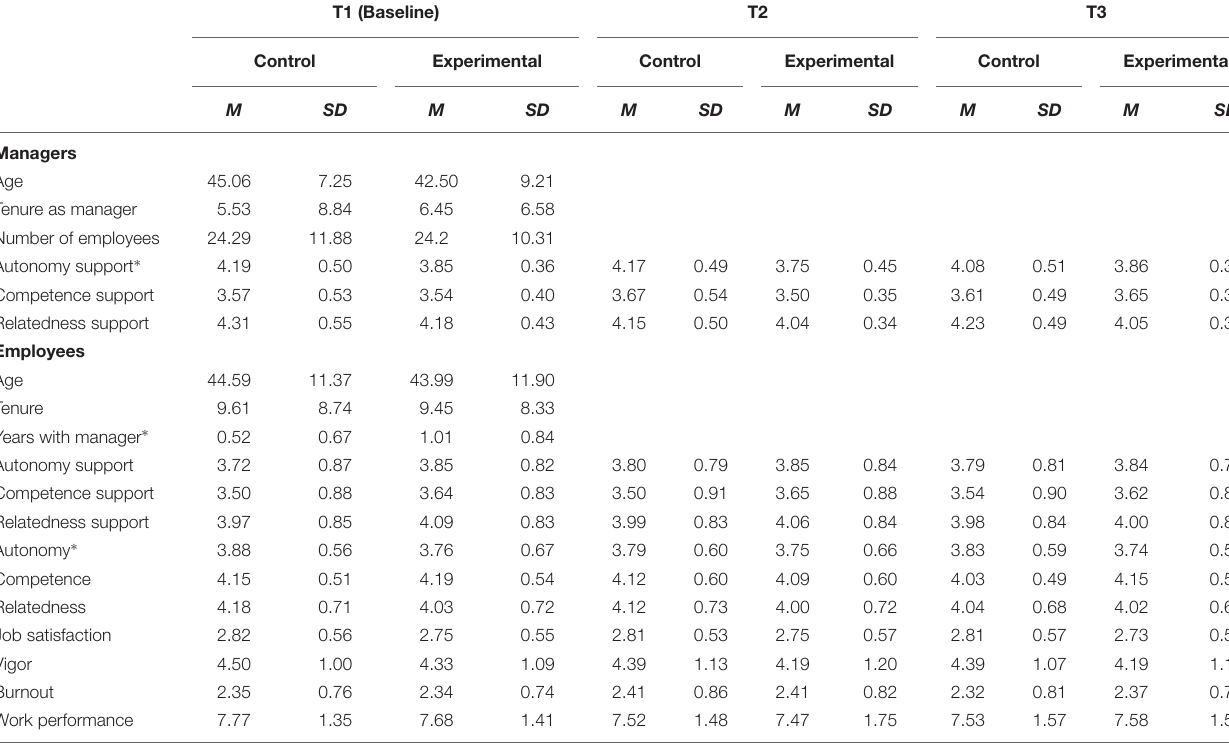
TABLE 1 | Characteristics of participants at baseline and descriptive statistics of the study